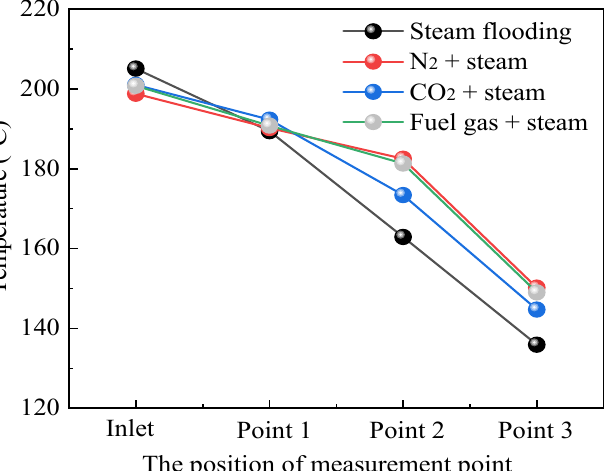
Figure 8. Temperature variation at temperature measurement points under different flooding modes: ( a ) pure steam flooding, ( b ) N 2 + steam flooding, ( c ) CO 2 + steam flooding, and ( d ) flue gas + steam flooding.